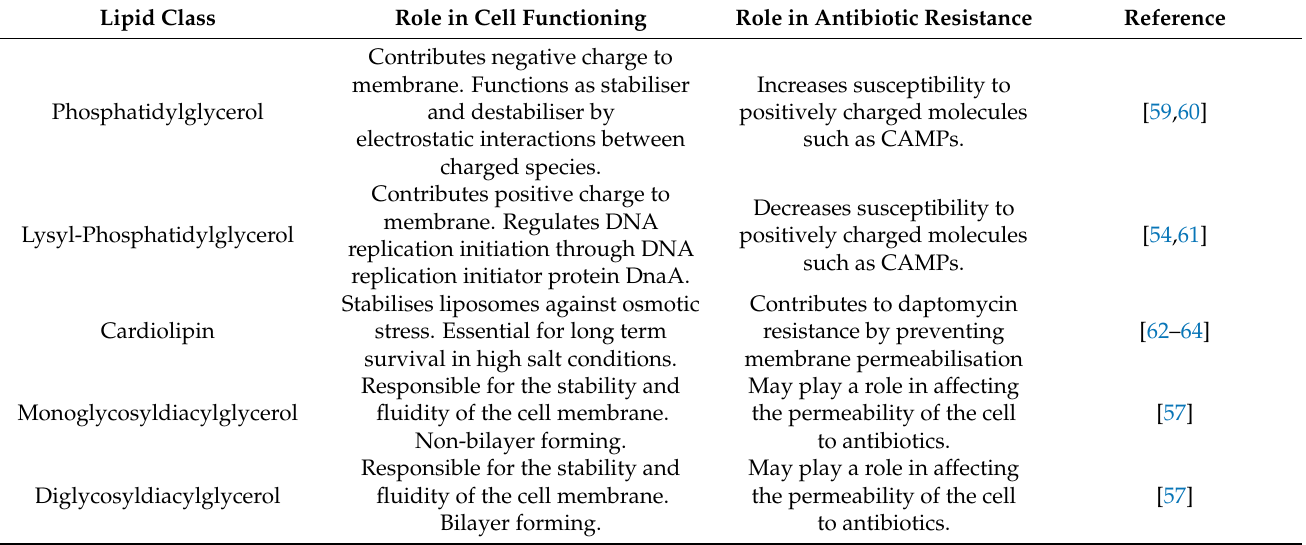
Table 2. Lipid classes present in the bacterial cell membrane, their role in the cell and their role in antibiotic